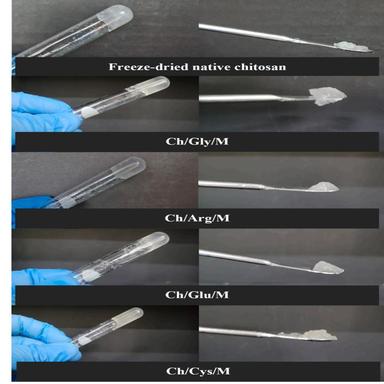
Photographs of the hydrated native chitosan and its permethylated derivatives.